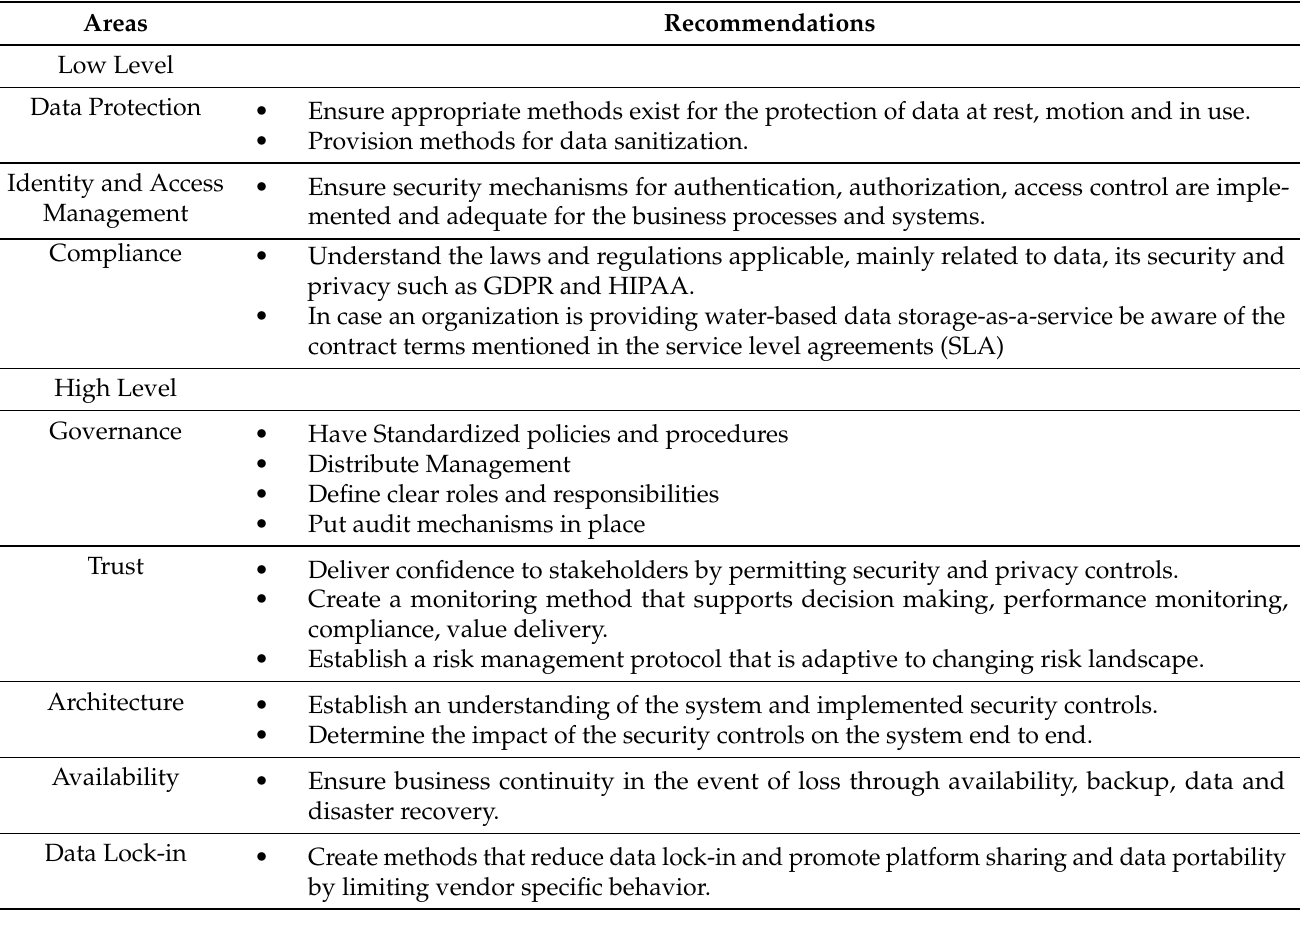
Table 1. Possible security and privacy concerns while storing data on